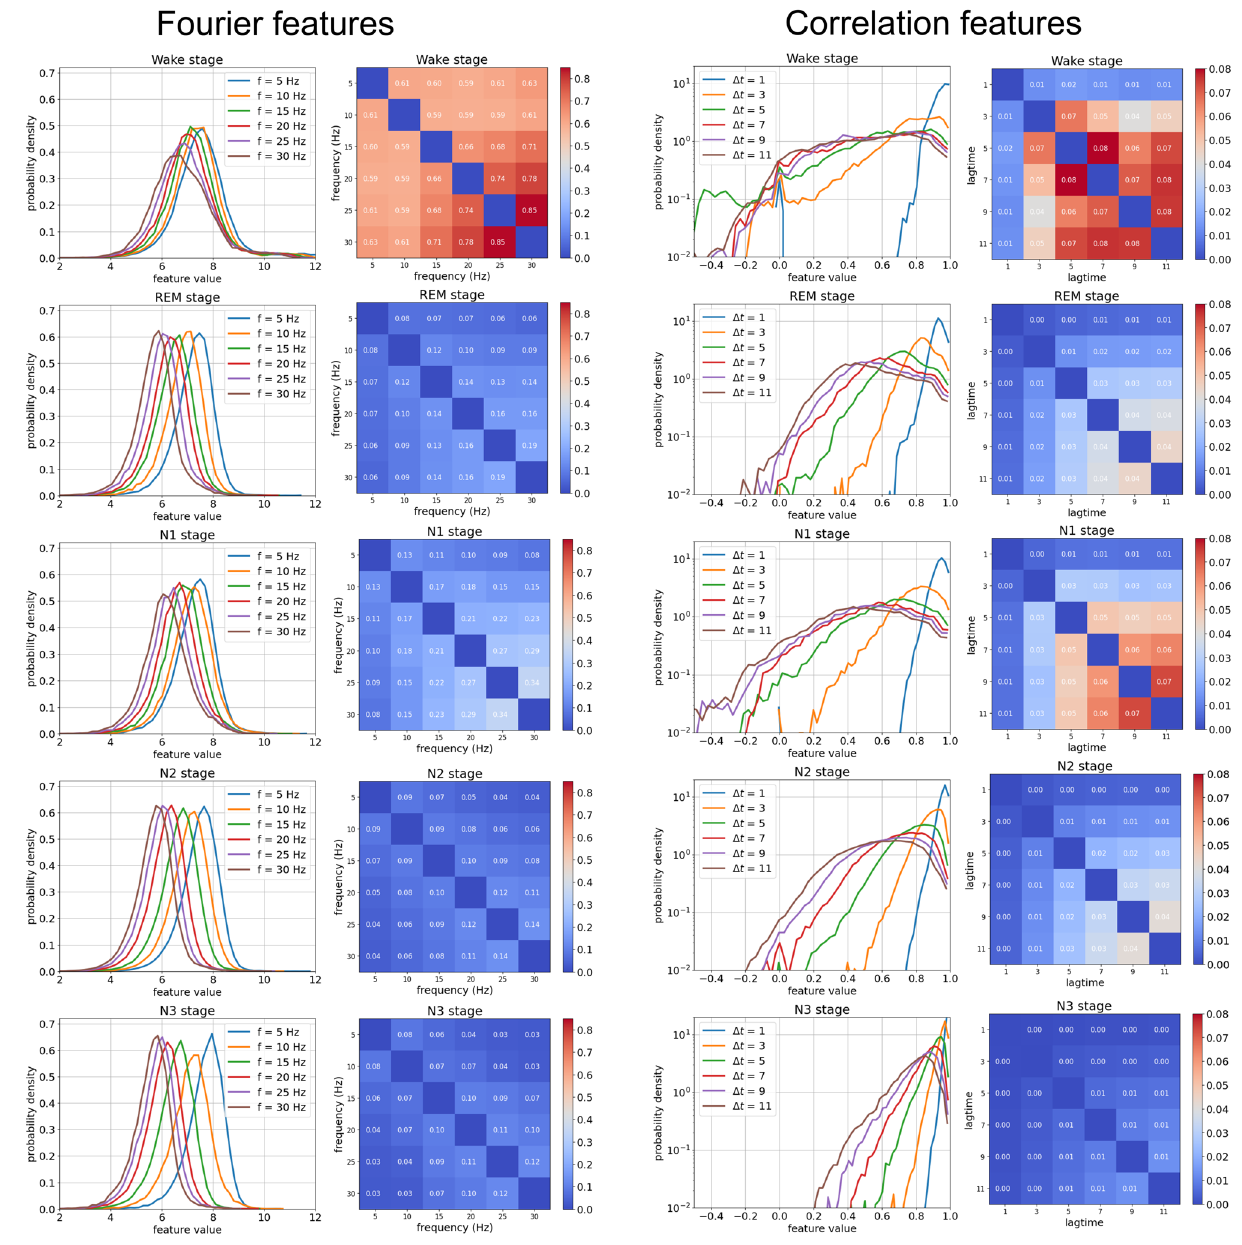
Figure 7. Distributions (Columns 1 and 3)) and covariances (Columns 2 and 4) of Fourier-based and correlation-based features, extracted from EEG-recordings of humans during sleep (See methods for details). The rows correspond to the five sleep stages s (Wake, REM, N1, N2 and N3). In the covariance matrices, the relatively large diagonal elements are suppressed for better visibility of the inter-feature correlations. The probability distributions p s ( u f ) in row 1 are approximately Gaussian, whereas the distributions p s ( u � t ) in row 3 are highly non-Gaussian. All distributions change in a systematic way with the feature parameters (frequencies f of Fourier modes, lag-times (cid:31) t of auto-correlations). Both the distributions and covariances also show characteristic differences between the sleep stages s , which can be exploited for automatic